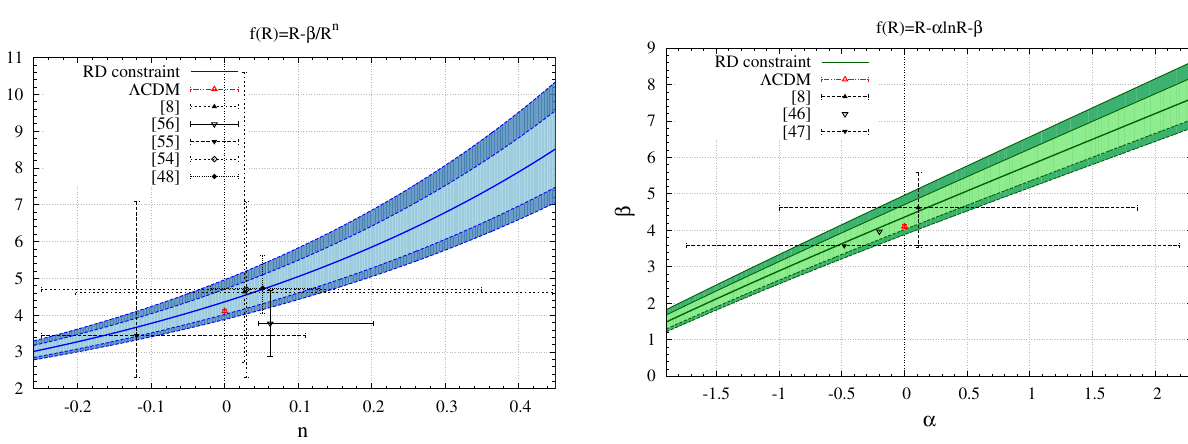
Fig. 1 Constrainton the parameterspace ( n ,β) for theories of the type f ( R ) = R − β/ R n coming form the cosmographic approach to the redshift drift, together with the best-fit values previously reported and the Λ CDM case. The shadowed regions indicate the error propagation associated to the Ω m , 0 and q 0 values, and a forecast corresponding to a measurement of q 0 with an error of 10% of its value